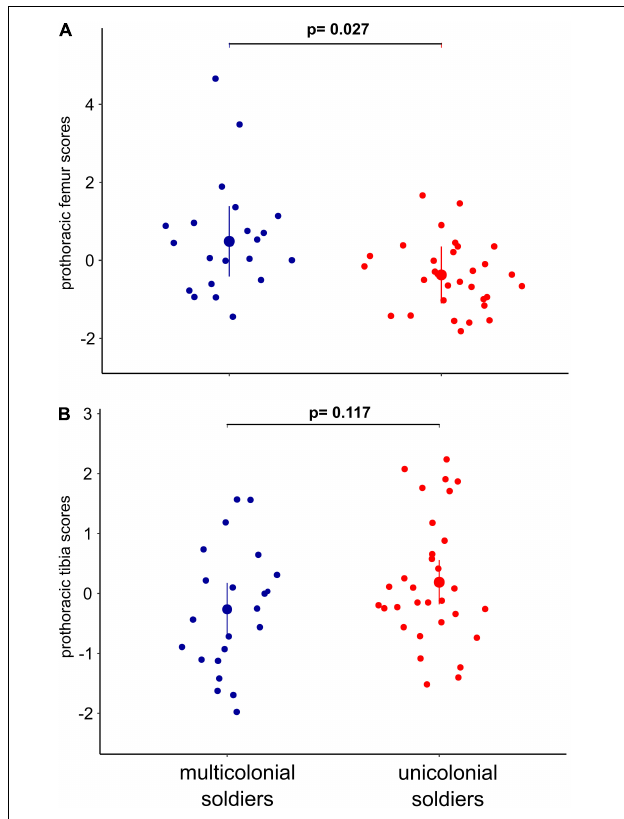
FIGURE 3 | Soldiers’ prothoracic femur (A) and prothoracic tibia (B) principal components from FA1 indexes among soldiers from multicolonial and unicolonial substrates. In the plot, the modeled means are represented by large circles, bars are the modeled 95% confidence intervals of each mean, and the model-adjusted individual response values are represented by the small dots. Scores were obtained from PCA of fluctuating asymmetry indexes (FA1). P -values indicate significance at p < 0.05. TABLE 3 | Fluctuating asymmetry index 10 (FA10) of four morphological traits of soldiers of N. chilensis from multicolonial and unicolonial substrates. Morphological Soldier FA10 ( σ 2 ) Statistics trait